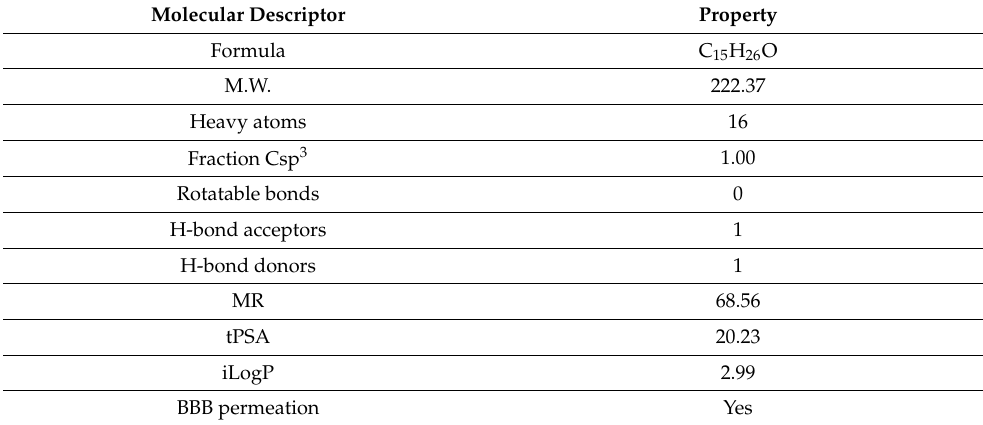
Table 6. Predicted physicochemical properties of (+)-cedrol according to SwissADME results.